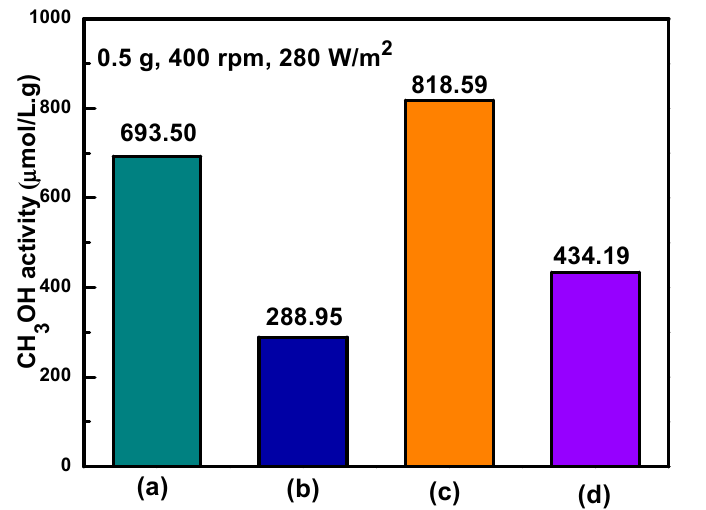
Figure 6. Photocatalytic activity histogram of ( a ) CuIm ( b ) CuZrIm0.5 ( c ) CuZrIm1 ( d ) CuZrIm1.5. The inclusion of bimetallic Cu-Zr on imidazolate framework promotes the photocat- alytic activity of CuZrIm which is beneficial in separating the photo-generated electron-hole pairs. However, beyond the critical Zr mass ratio (i.e., 1.5 mmol) in bimetallic photo- catalyst, a decay in the photocatalytic activity is apparent. This could be due to the de- creasing number of available surfaces as the Zr content increases. Therefore, 1 mmol of Zr mass ratio is enough for synthesizing CuZrIm catalyst because the CO 2 molecules can be easily adsorbed. However, an excessive amount of Zr would block the active sites of CuZ- rIm. As a result, the number of available surfaces of the catalyst interacting with the CO 2 molecules is lesser. Moreover, a high mass ratio of Zr leads to light scattering and blocks absorption of visible light by CuIm photocatalysts and shows less photocatalytic activity in the production of methanol [31]. 2.3. Optimization Study The research work discussed in this part of the paper primarily deals with the re- sponse of methanol yield influenced by various process variables. The main objective of the research in this section is to optimize the methanol yield along with the stirring rate, the intensity of light and catalyst loading. RSM is usually performed upon screening the previous design to determine the influential experimental variables. A system response might be affected by numerous variables; therefore, it is practically impossible to consider all these variables during the analysis. In other words, only those significant variables should be chosen [32]. In this work, the Box-Behnken design tool of RSM is employed for selected three fac- tors. Fair conditions for methanol synthesis were stirring rate, the intensity of light and catalyst loading. Before application RSM, these conditions were determined by changing one variable at a time while keeping other variables constant. Table 2 summarizes the essential variables that produce significant effects on methanol yield. All these factors are selected by experiments. Table 2. Levels and variables for the Box-Behnken design. Variable